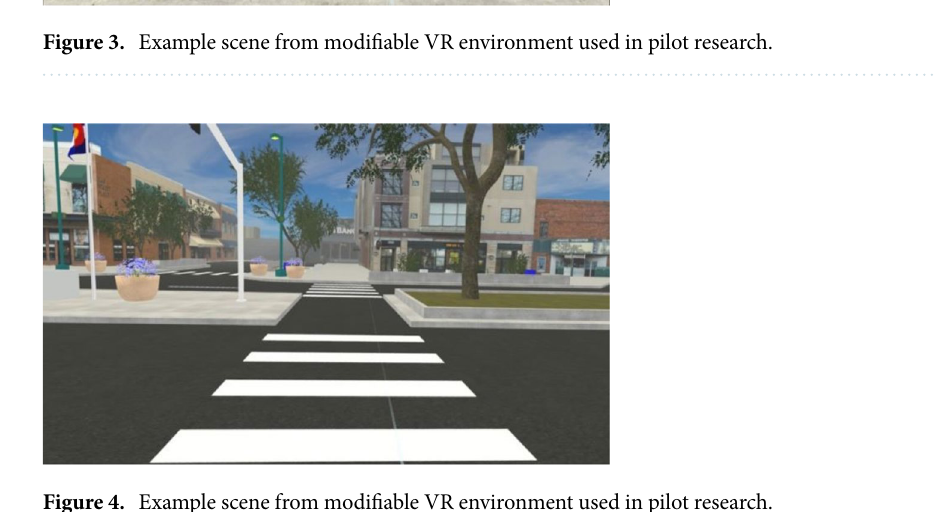
Figure 4. Example scene from modifiable VR environment used in pilot